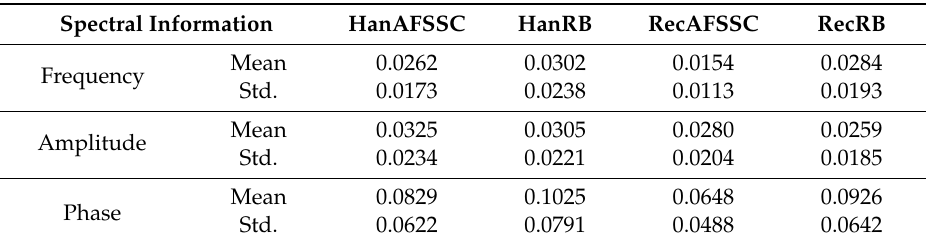
Table 4. Comparisons of the four techniques when f c =